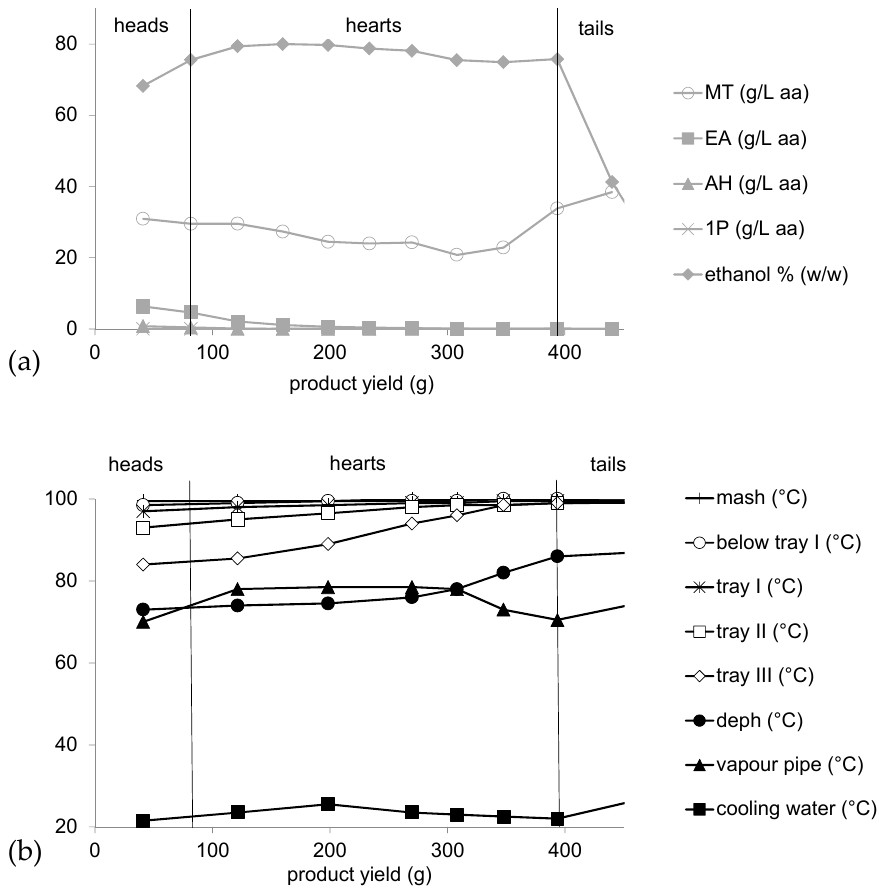
Figure 4. Fermentative volatiles ( a ) and process parameters ( b ) during distillation. deph = Figure4. Fermentativevolatiles( a )andprocessparameters( b )duringdistillation. deph = dephlegmator, dephlegmator, MT = methanol, EA = ethyl acetate, AH = acetaldehyde, 1P = 1-propanol, MT = methanol, EA = ethyl acetate, AH = acetaldehyde, 1P = 1-propanol, concentrations based on concentrations based on anhydrous alcohol (aa). Last tailings fraction not shown. Note different anhydrous alcohol (aa). Last tailings fraction not shown. Note di ff erent y-axis y-axis scaling.